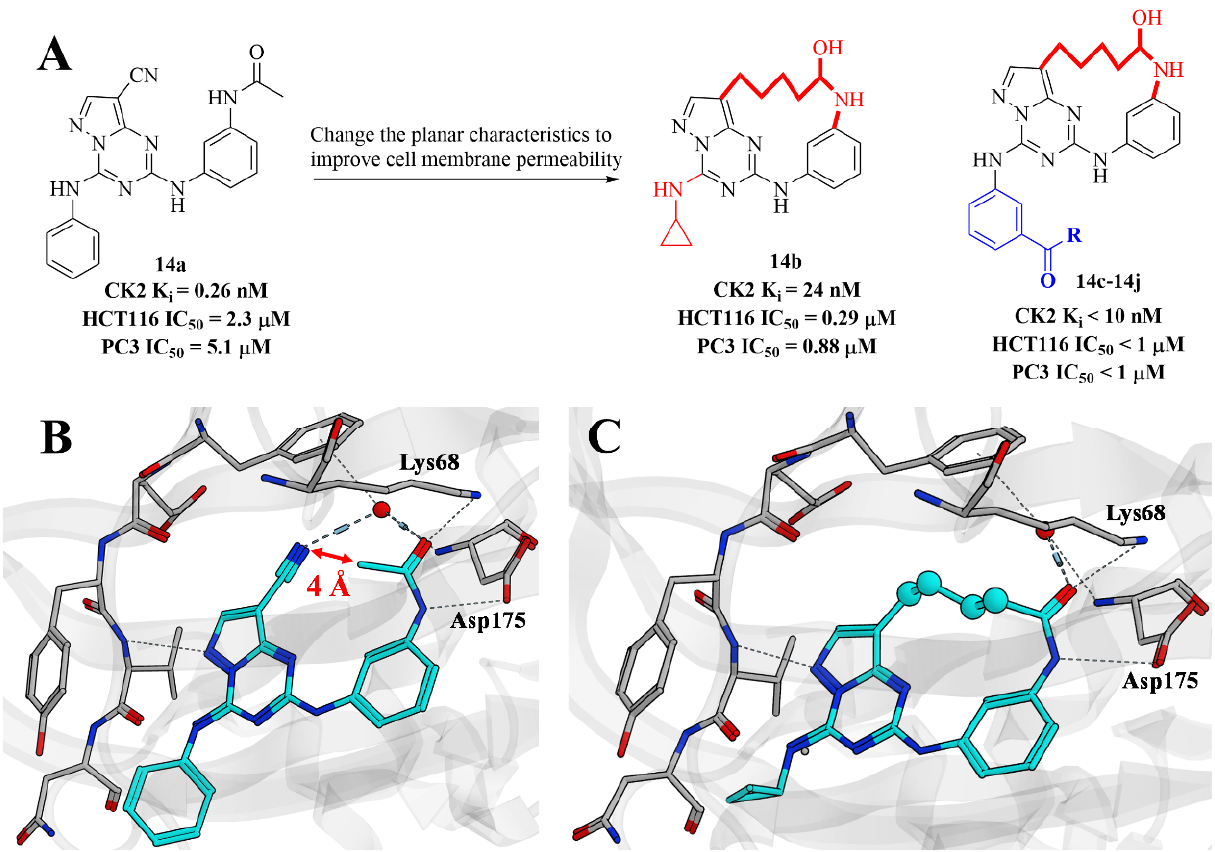
Figure 16. ( A ) Structural modification of macrocyclic CK2 inhibitors. ( B ) X-ray crystal structure of compound 14a bound to CK2 protein (PDB: 2PVN). ( C ) X-ray crystal structure of compound 14b bound to CK2 protein (PDB: 3BE9).